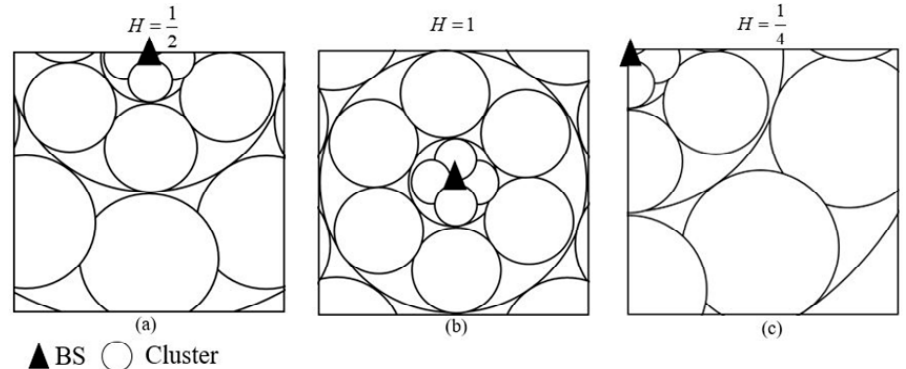
Figure 4. Different location of the BS in the monitoring area. ( a ) the BS is located on the boundary of the monitoring area, ( b ) the BS is located in the monitor area, ( c ) the BS is located on a vertex of the rectangle network area.